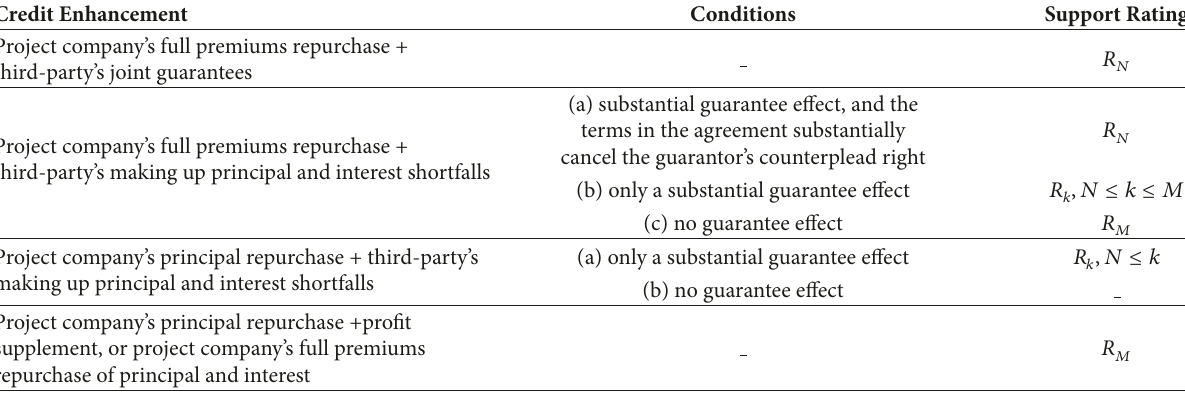
Table 4: Credit rating after the credit enhancement of various financing structures of equity-like